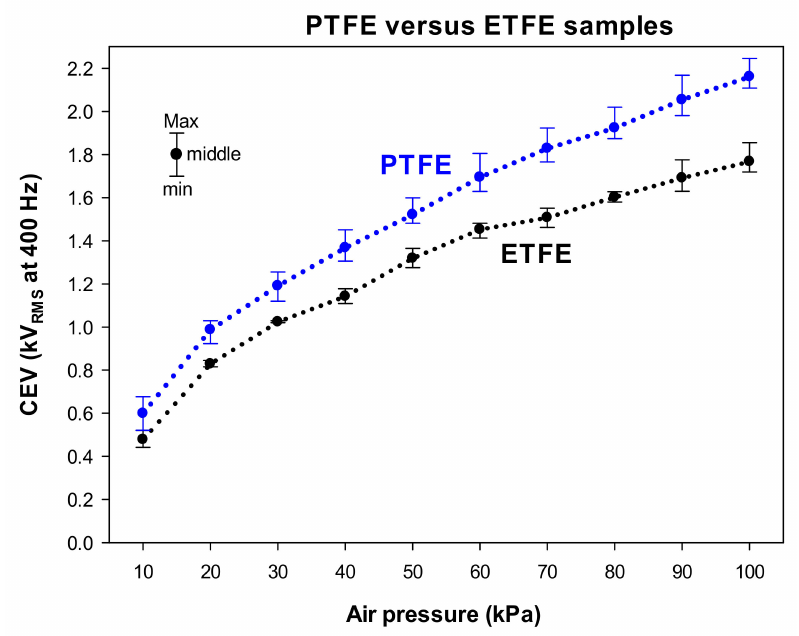
Figure 6. Comparative CEV values measured at 400 Hz of the analyzed PTFE and ETFE samples (three replicas each) in the 10–100 kPa interval covering the aeronautic pressure